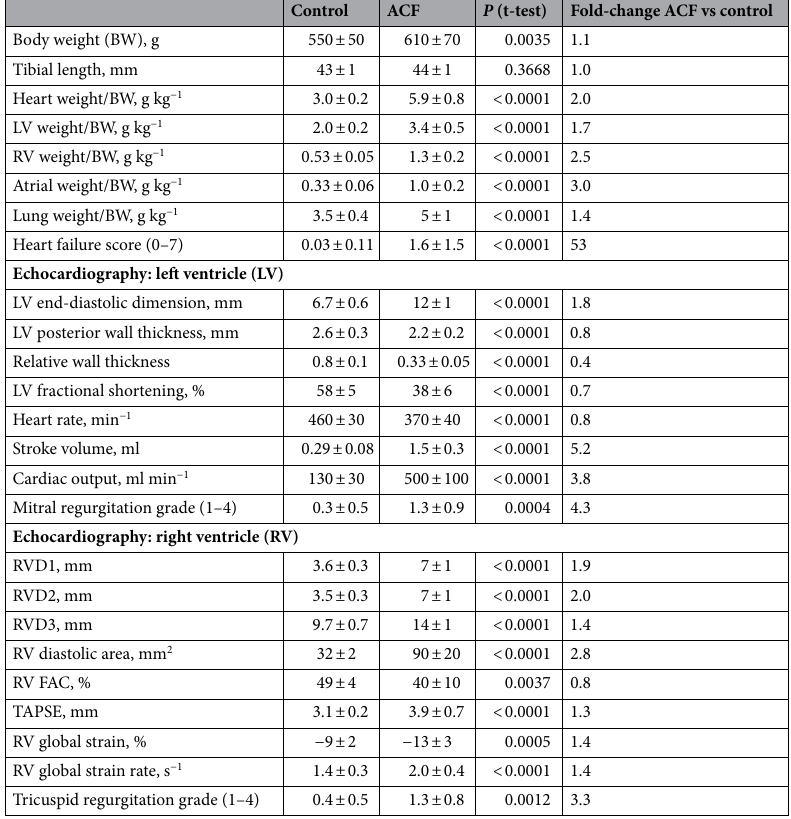
Table 1. Baseline characteristics and echocardiography. Values are expressed as mean ± SD. BW, body weight; LV, left ventricle; RV, right ventricle; RVD, right ventricular diameter; FAC, fractional area change; TAPSE, tricuspid annular plane systolic